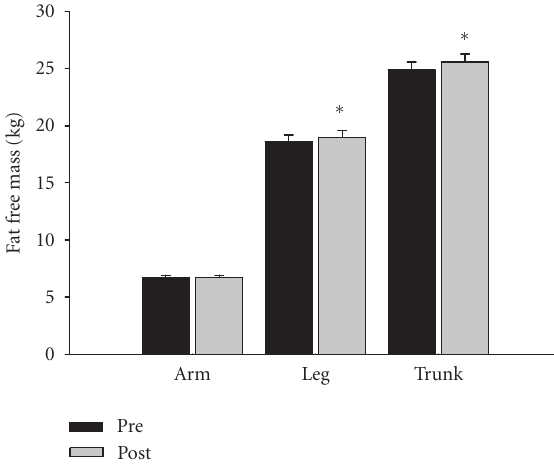
Figure 3: Visceral fat change for the high-intensity intermittent exercise and no exercise control groups ( N = 38; mean and standard error). ∗ Significantly di ff erent from control group ( P < 0 .